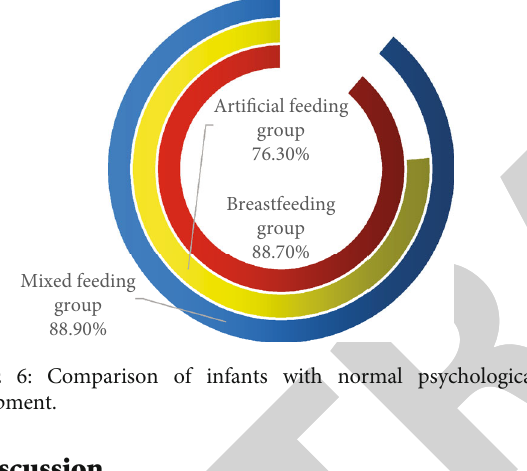
Figure 6: Comparison of infants with normal psychological